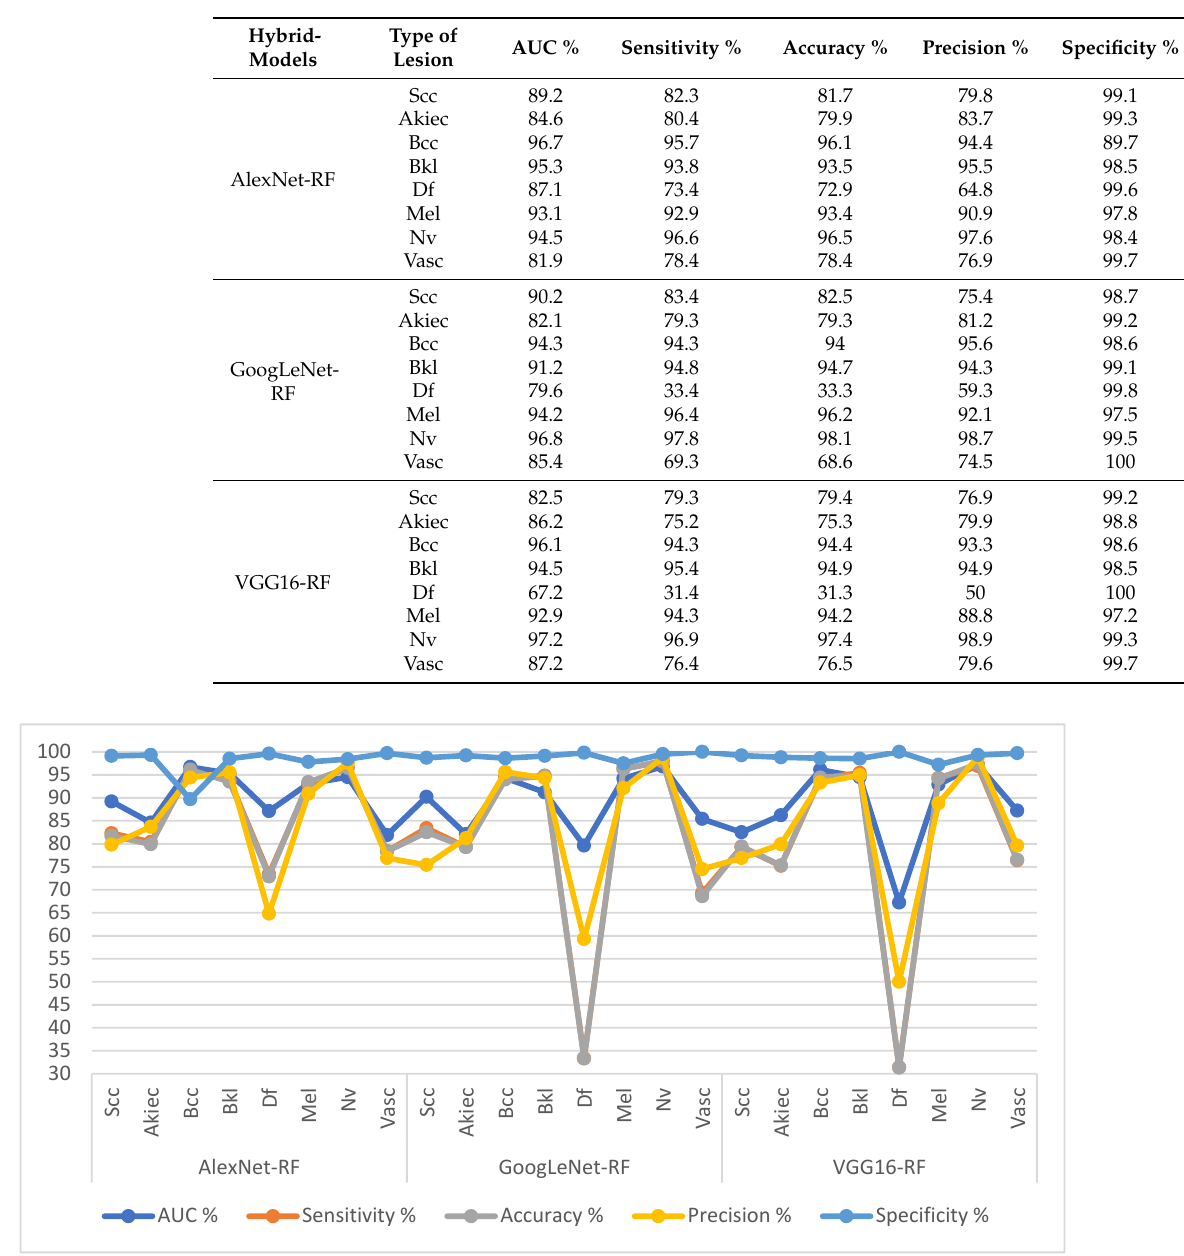
Table 6. Performance results of CNN-RF hybrid models based on ROI using the GAC method for early diagnosis and differentiation of skin cancer and other skin lesions.